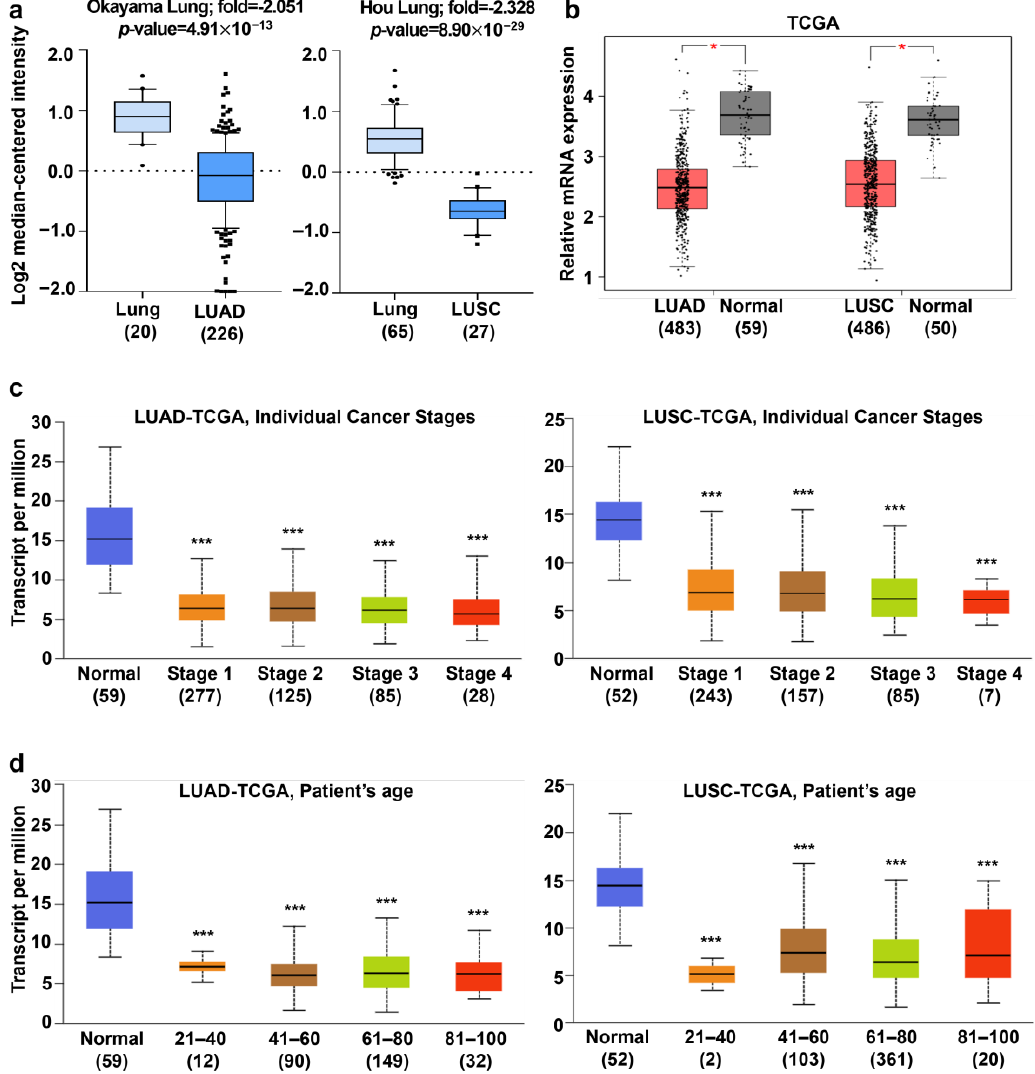
Figure 2. mRNA expression level of ATP/GTP binding protein 1 ( AGTPBP1 ) in human lung cancer tissues and normal tissues. ( a ) mRNA level of AGTPBP1 was downregulated in LUAD and LUSC, as determined from the Oncomine database. ( b ) The expression levels of AGTPBP1 in LUAD or LUSC and normal tissue counterparts from The Cancer Genome Atlas (TCGA) database were compared using Gene Expression Profiling Interactive Analysis (GEPIA). ( c , d ) mRNA expression level of AGTPBP1 according to the stage of cancer and patient’s age in LUAD and LUSC as compared to adjacent normal tissues. Statistical significance was determined using fold-change threshold > 2 in the Oncominedatabase and p- value threshold < 0.05 in all databases. LUAD, lung adenocarcinoma; LUSC, lung squamous cell carcinoma (*: p < 0.05; ***: p < 0.001).